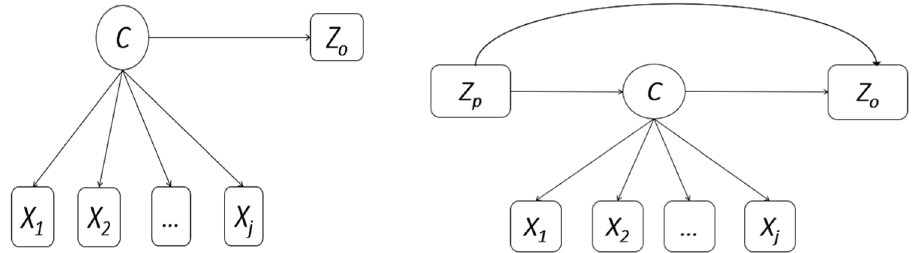
Figure 1. Graphical representation of latent class model with distal outcome and covariate. Where C = latent class, X 1 , X 2 , …, X J refer to latent class indicators of C, Z o = distal outcome, and Z p = covariate of the latent class variable C and distal outcome Z o